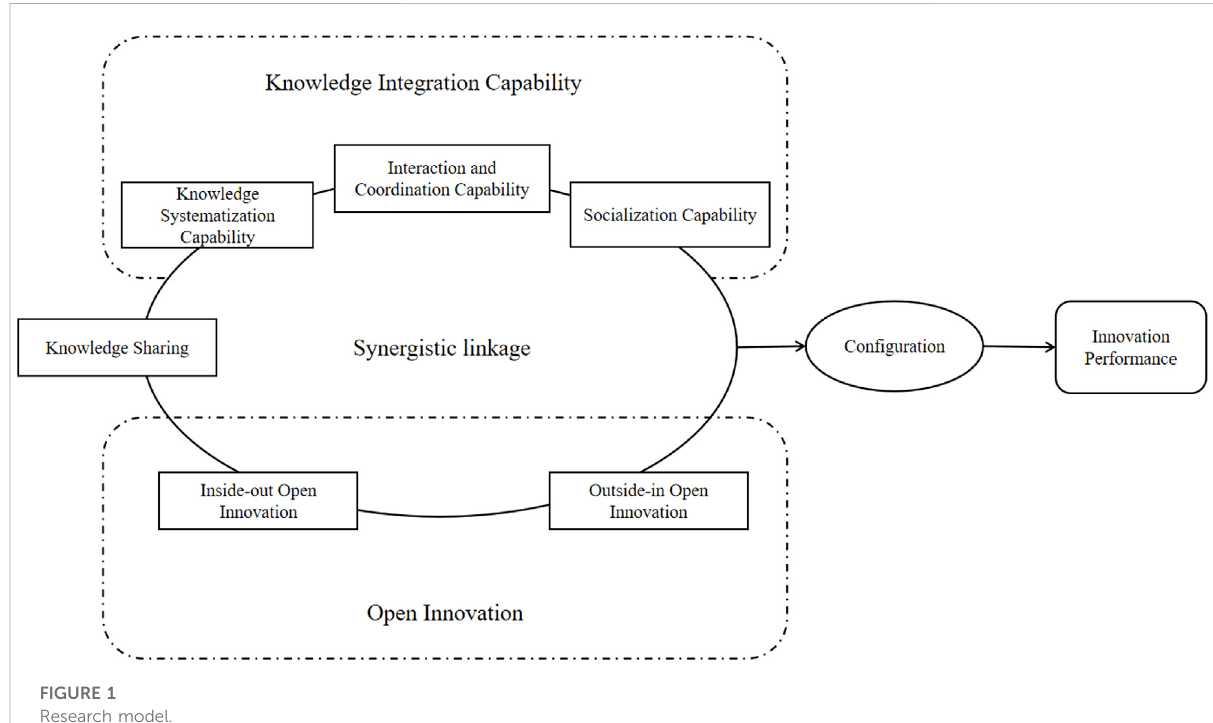
FIGURE 1 Research